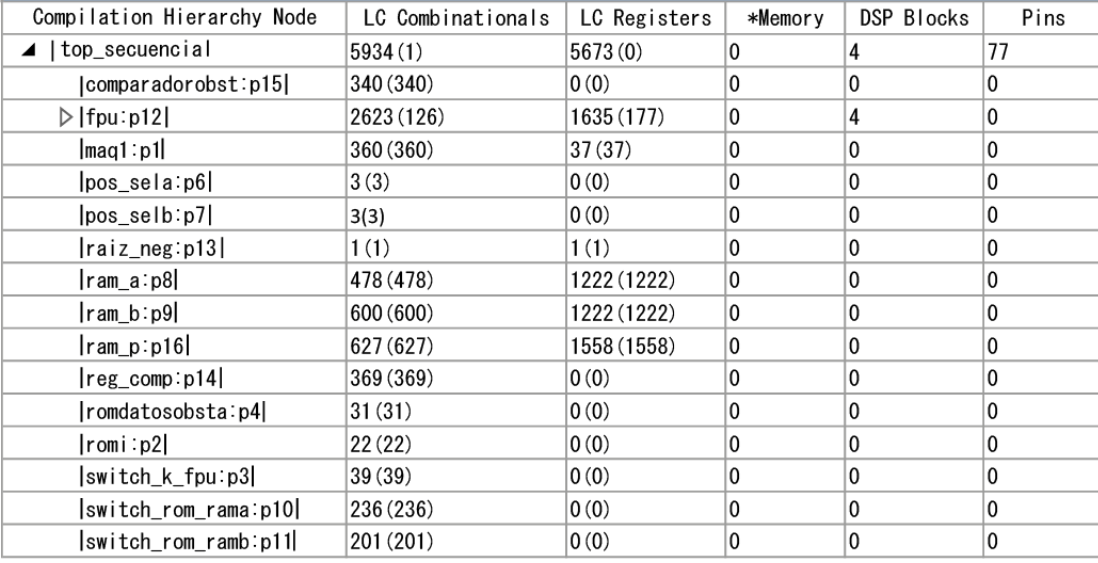
Figure 15. FPGA resource